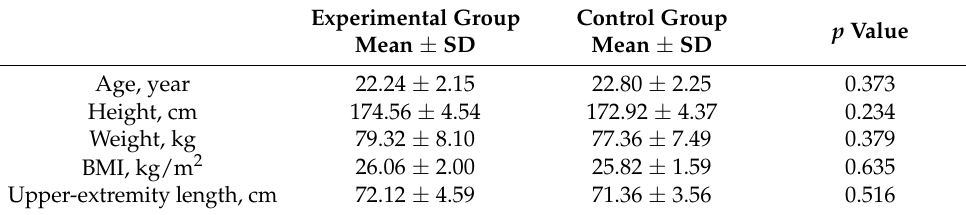
Table 1. Demographic data of the participants.